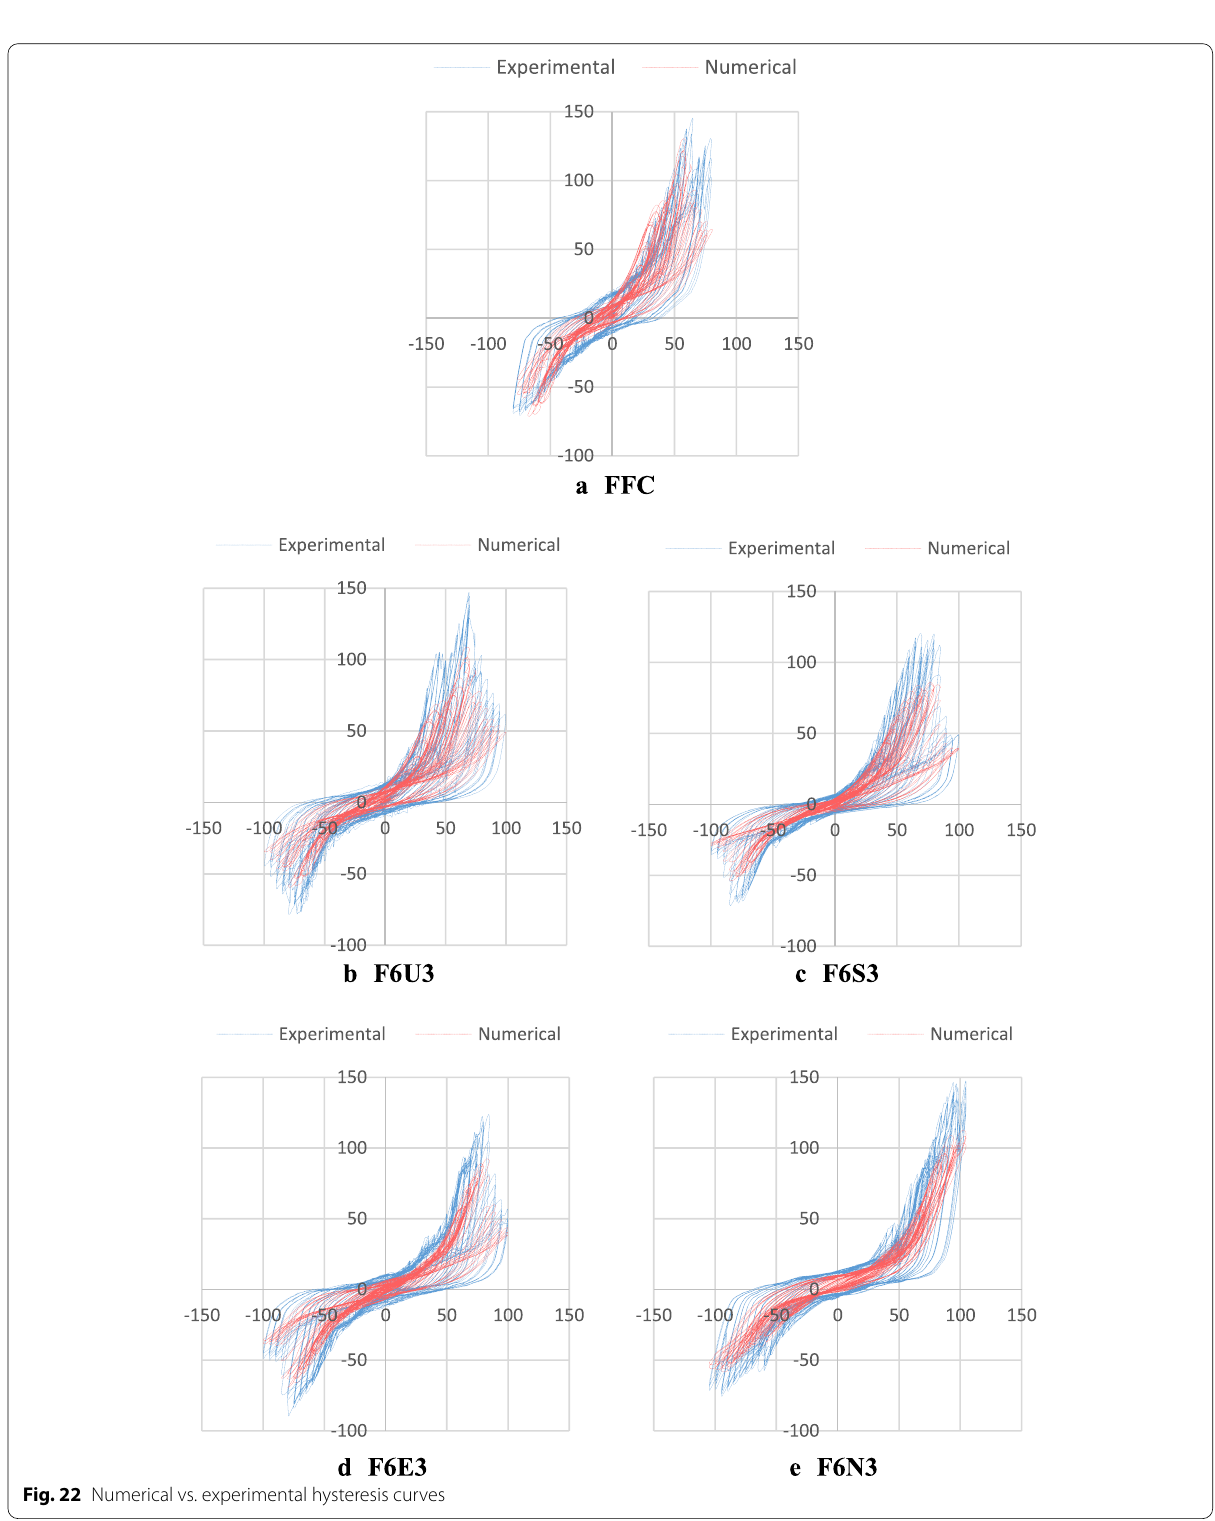
Fig. 22 Numerical vs. experimental hysteresis